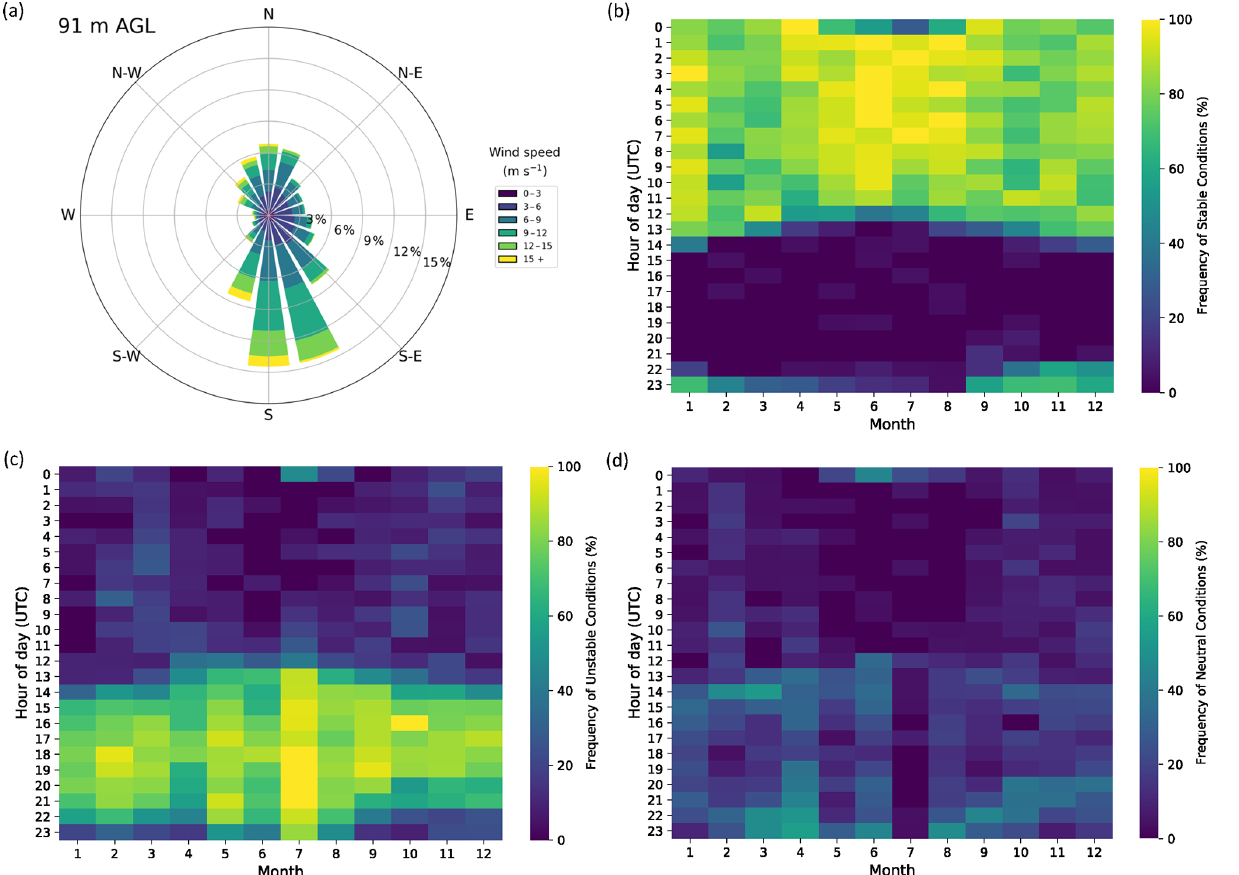
Figure 2. (a) Wind rose showing the distribution of wind speeds at 91ma.g.l. for 2018, using lidar observations at the SGP Central Facility site. (b) The 24 × 12 heat map of the frequency of stable conditions at the site, classified in terms of the surface Obukhov length. (c) Same but for unstable and (d) neutral